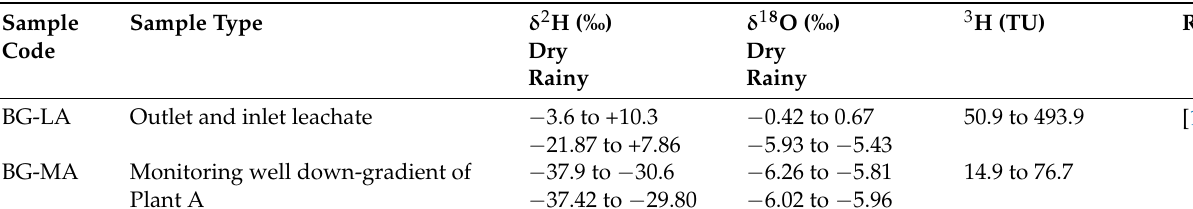
Table 2. Isotope data of leachate and monitoring well.